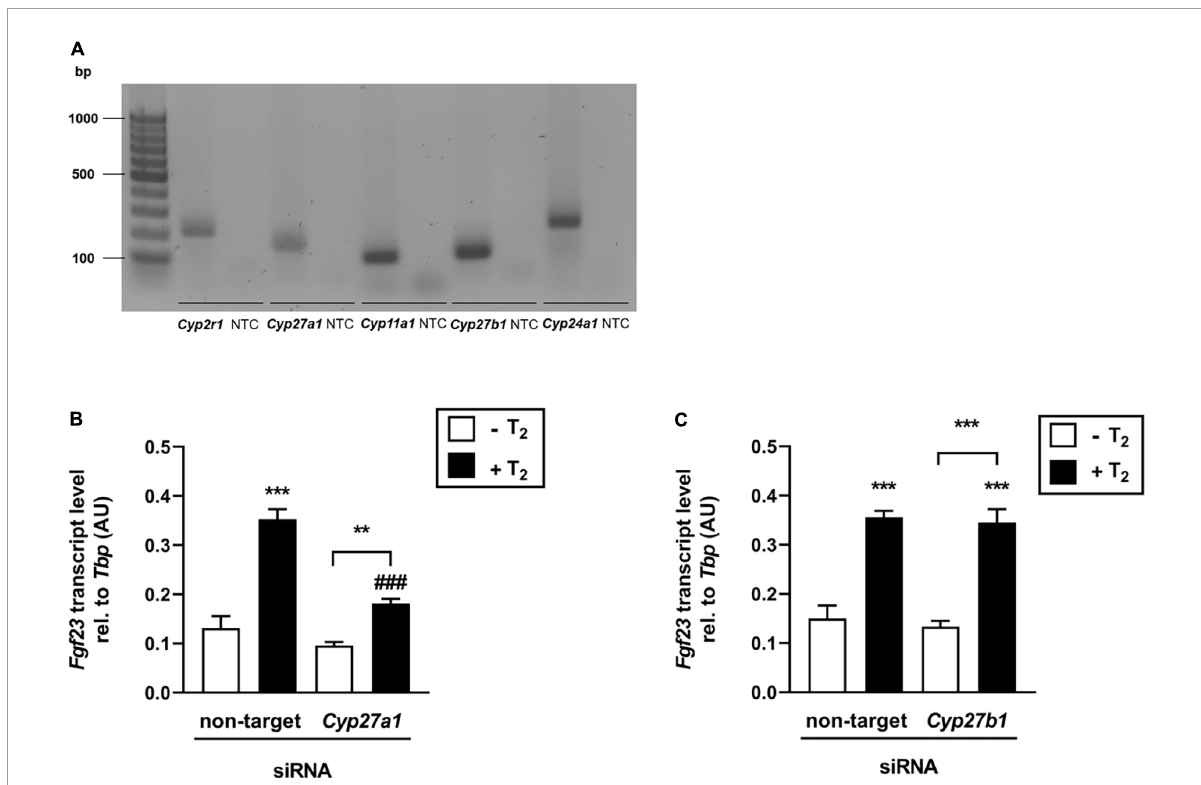
FIGURE4 The effect of tachysterol 2 on Fgf23 transcription is at least partially dependent on Cyp27a1. (A) Original agarose gel photograph showing amplified Cyp2r1 -, Cyp27a1 -, Cyp11a1 -, Cyp27b1 - or Cyp24a1 -specific cDNA in untreated UMR106 cells. (B,C) Arithmetic means ± SEM of relative (rel.) Fgf23 mRNA abundance (normalized to Tbp ) in UMR106 cells incubated with non-targeting or Cyp27a1 -specific ( B , 100 nM, 96 h, n = 6) or Cyp27b1 -specific ( C , 100 nM, 96 h, n = 6) siRNA in the absence (white bars) or presence (black bars) of T 2 (25 µ M, 24 h). Treatment with Cyp27a1 -specific or Cyp27b1 -specific siRNA resulted in a 53% reduction of relative Cyp27a1 mRNA (B,C) 50% reduction of relative Cyp27b1 mRNA expression compared to non-targeting siRNA as control. ** p < 0.01 and *** p < 0.001 indicate significant differences from control. ### p < 0.001 indicates a significant difference from the absence of Cyp27a1 -specific siRNA (2nd vs. 4th bar). bp, base pairs; NTC, non-template control; AU, arbitrary units ( B,C one-way ANOVA